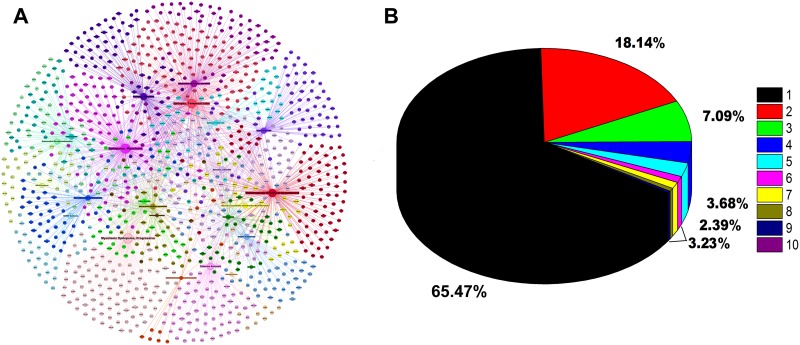
Refractory Epilepsies (RE) disease-gene network and relationships statistics.(A) Disease-gene network showing the relationships of 1,086 genes corresponding to 23 MeSH Headings. The long label big nodes denote diseases in MeSH terminologies; the small nodes denote genes. The size of the node is positively related to the number of linked genes. Different colors represent different diseases. Genes located in the center of the network are associated with several diseases (e.g. SCN1A, KCNQ2). Genes located at the periphery of the network are associated with a single disease (e.g. CHRNA5, CHRNB4). (B) The gene-related MeSH heading numbers are distributed from 1 to 10, with different numbers for different colors. The total number of seed genes is 1086, of which 711 (accounting for 65.47%) are only associated with one disease subtype (MeSH heading).